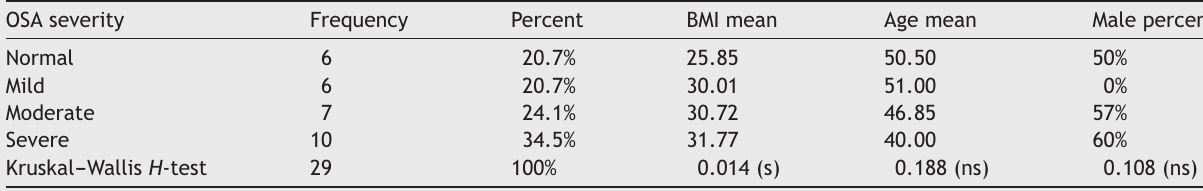
Description of OSA severity according to AHI.